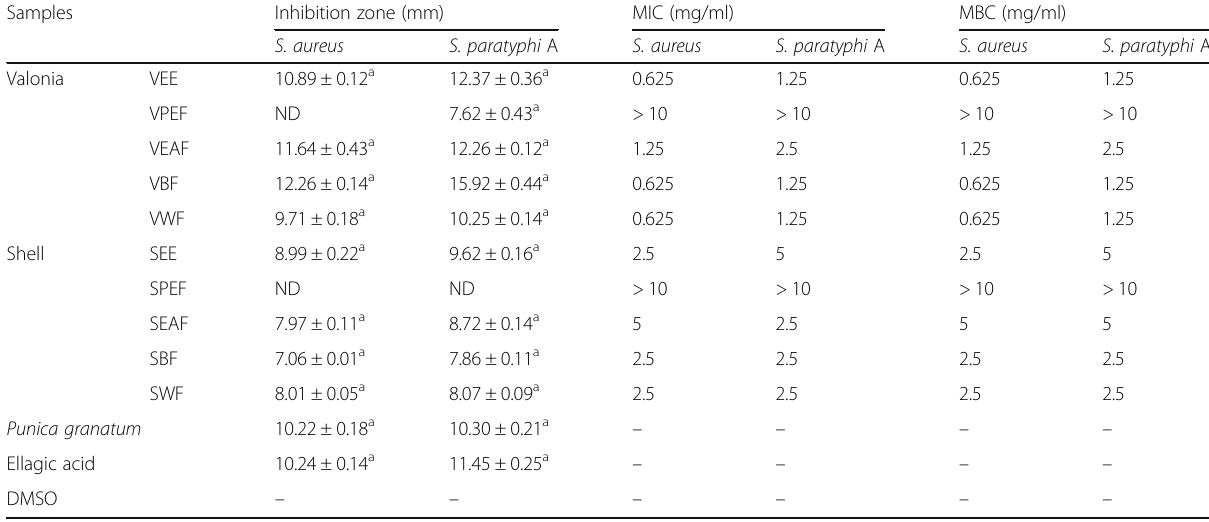
Table 5 Antibacterial activities of valonia and shell extracts from Q. variabilis against S. aureus and S. paratyphi A Samples